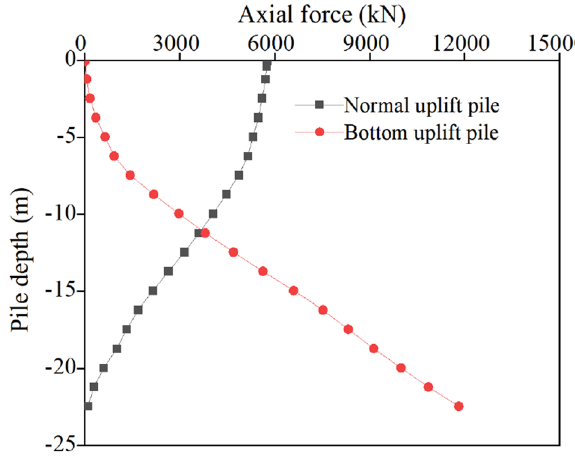
Figure 7. Axial force distribution of the uplift pile.